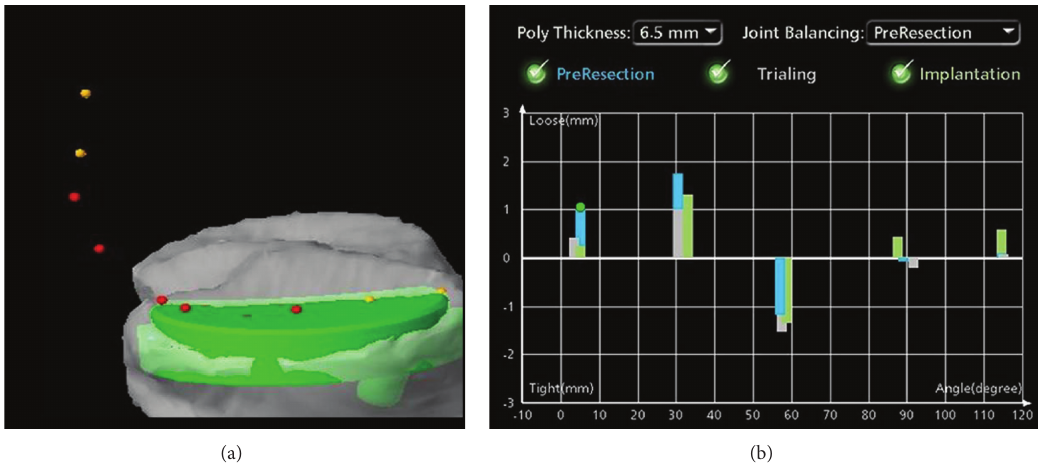
Figure1:Ligamentbalancingwasmeasuredthroughoutvariousanglesduringtheflexion-extensioncyclerelativetotibiaandmechanicalaxis. (a) The colored dots represent measurements during femoral range of motion. (b) Intraoperative screenshot of the robotic system showing ligament balance at 0 ∘ , 30 ∘ , 60 ∘ , 90 ∘ , and 110 ∘ of flexion before resection, with the trial component in place, and after